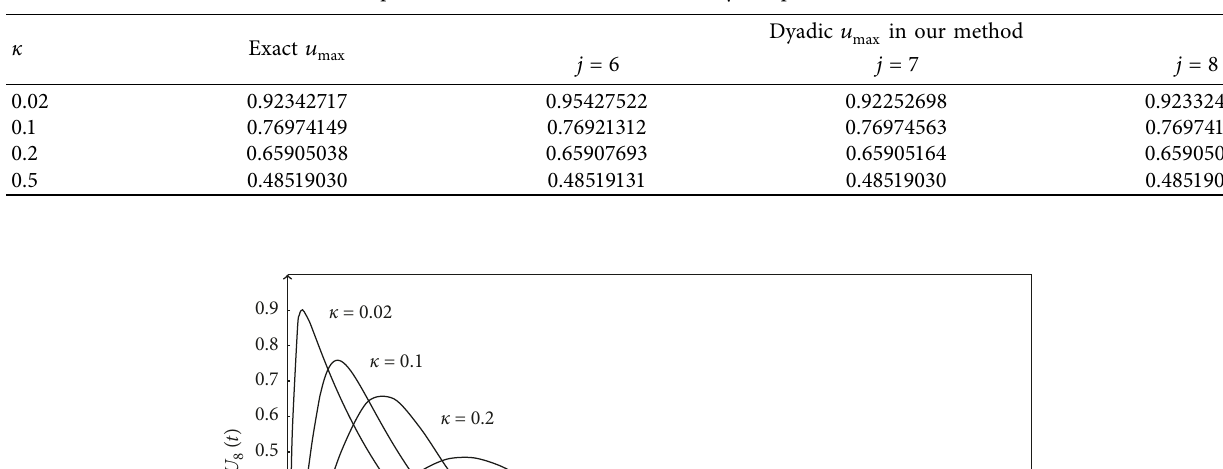
Table 3: A comparison between our method at the dyadic point with the exact